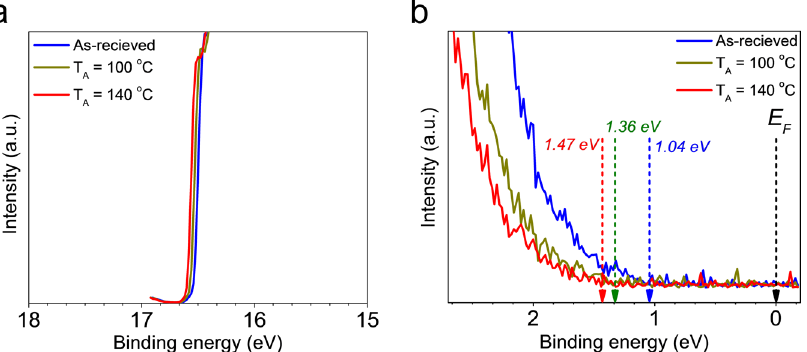
Figure 2. UPS analysis of the PDPP3T. ( a ) Cutoff region. ( b ) Fermi-edge regions. Blue line: as-received. Green line: vacuum annealing at 100 °C. Red line: vacuum annealing at 140 °C.